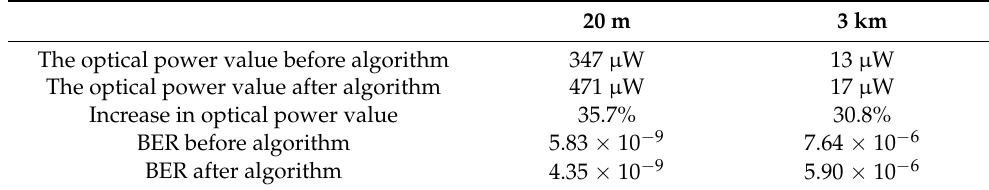
Table 4. The changes in optical power value and bit error rate before and after adding the AdaDelSPGD algorithm at different distances.